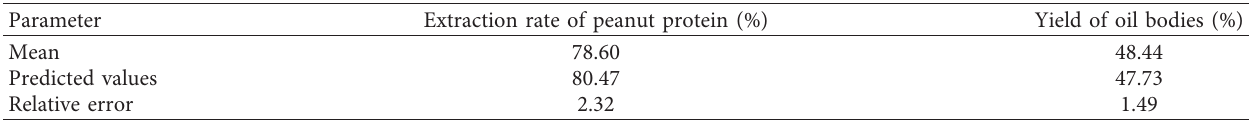
Table 4: Experiment data for test validation.